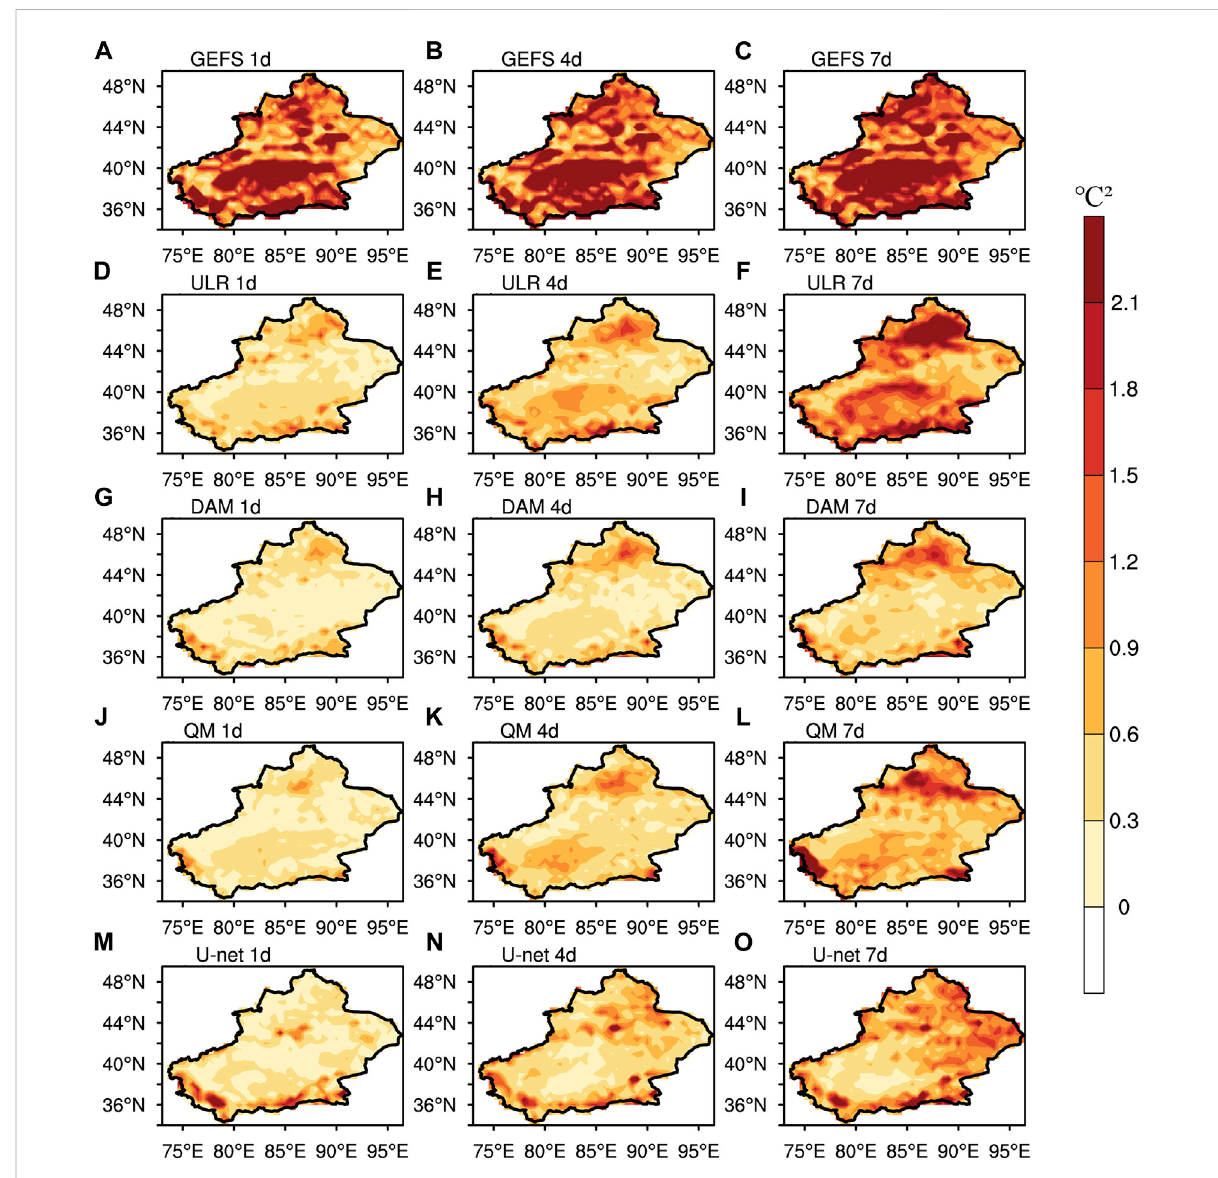
FIGURE 11 Spatial distributions of Distribution ( ℃ 2 ) with lead times of 1, 4, and 7 days derived from the MSE decomposition of GEFS (A – C) , ULR (D – F) , the DAM (G – I) , QM (J – L) and U-net (M – O)